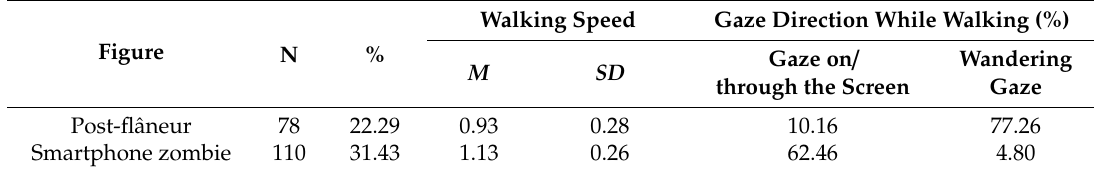
Table 3. Summary of the